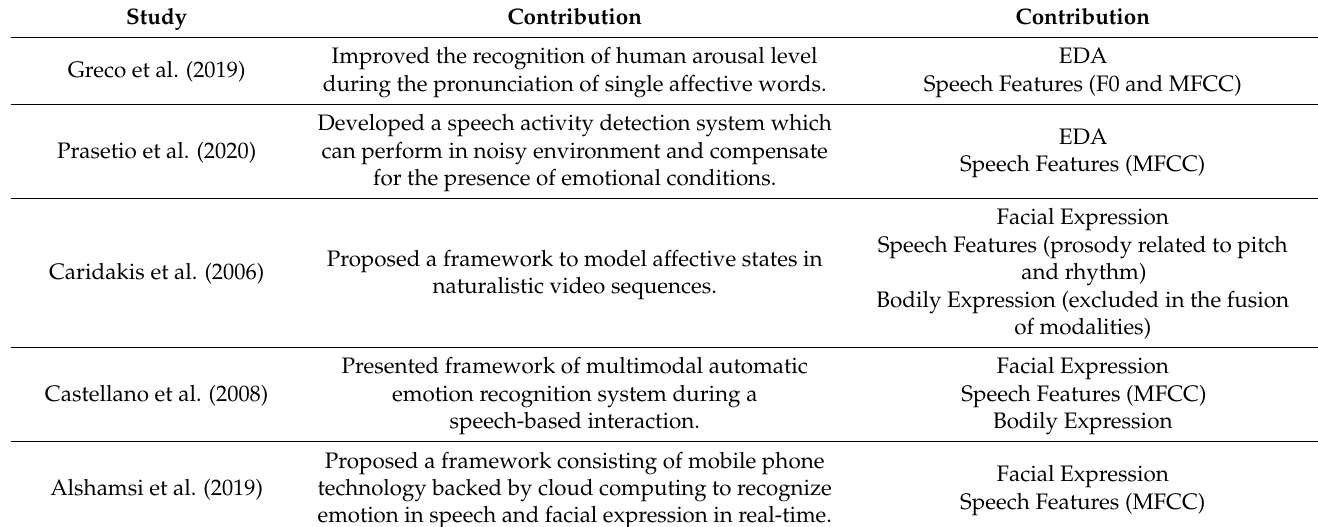
Table 2. Summary of the multi-method studies utilizing speech and physiological measures in relation to emotion